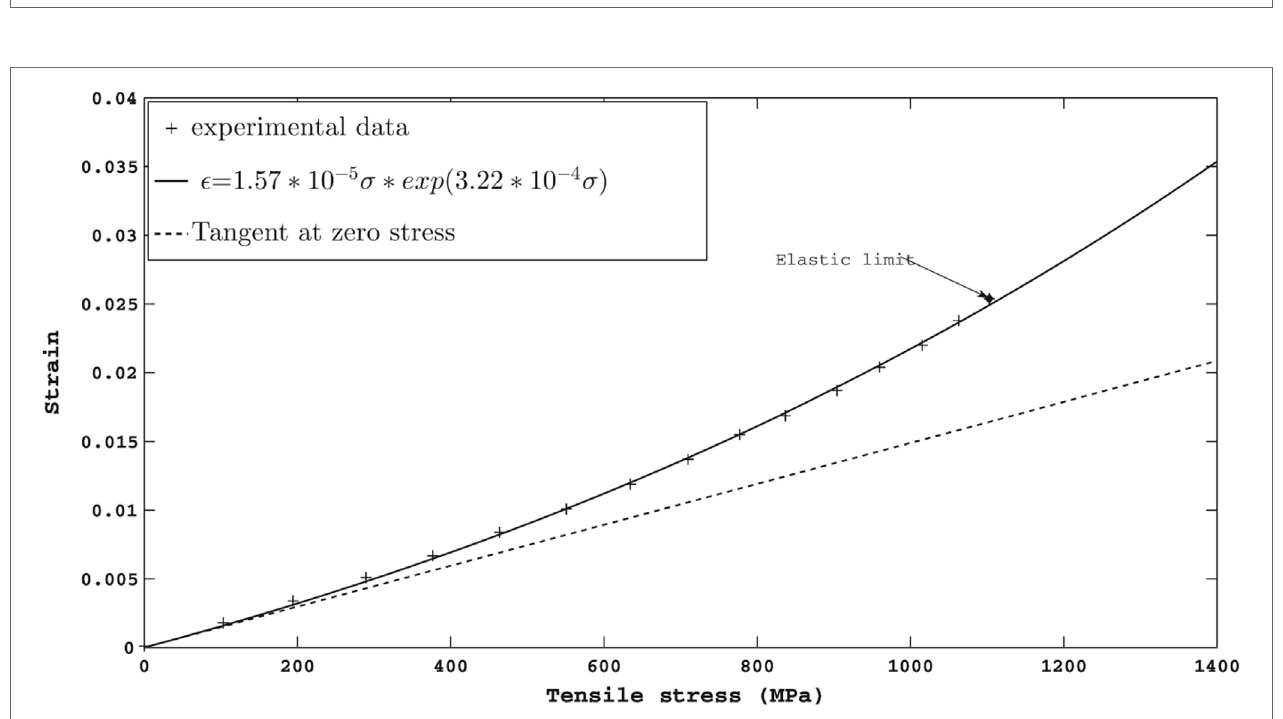
FigURe 6 | Fit of experimental data of by Boltenhagen et al. (1997) by Perlácová and Pru˘ša (2015) . The qualitative nature of the curve belongs to precisely the same class of models introduced by Le Roux and Rajagopal